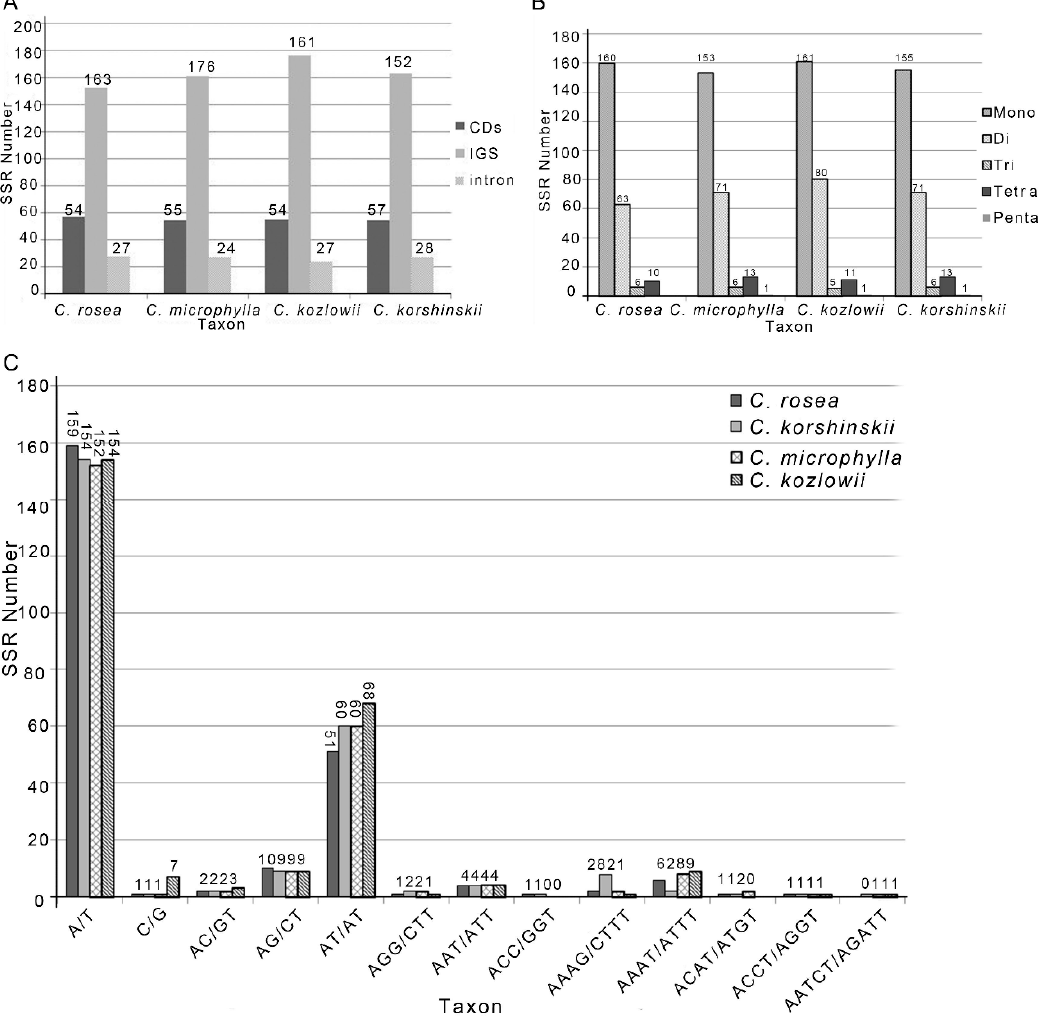
Figure 2. Statistics of simple sequence repeat (SSRs) detected in the plastome of four Caragana species. ( A ) Numbers of SSRs found in the coding (CDS), intergenic (IGS), and intronic regions, respectively; ( B ) number of different SSR types identified in the four genomes; and, ( C ) number of identified SSR motifs in different repeat class types.